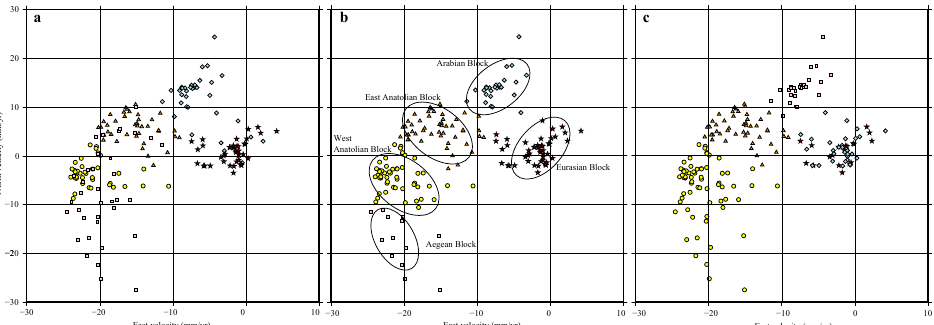
Figure 7. Ensemble results gathered from five clustering algorithms for horizontal GPS-derived velocity field in velocity space: ( a ) HGBF; ( b ) MCLA; ( c ) NMF methods. The colors and the shapes are the same as the map view of the locations in the previous